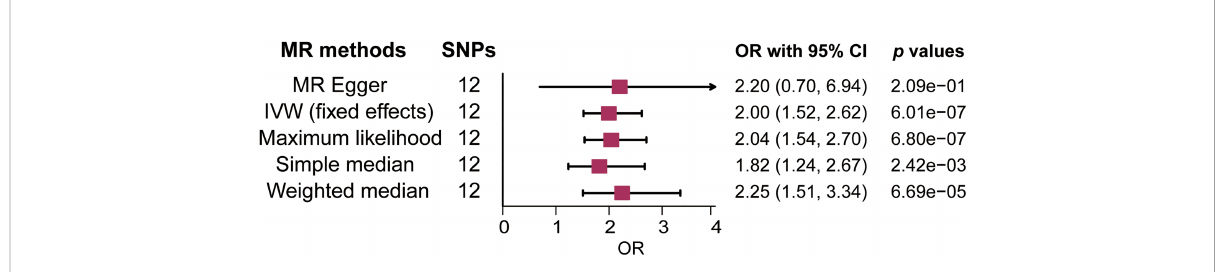
FIGURE 2 Forest plot of the association between genetically predicted leukocyte telomere length (LTL) and multiple sclerosis (MS). OR means a change in MS risk associated with a 1- standard deviation decrease in genetically determined LTL. SNP, single-nucleotide polymorphism; OR, odds ratio; CI, con fi dence interval; IVW, inverse variance